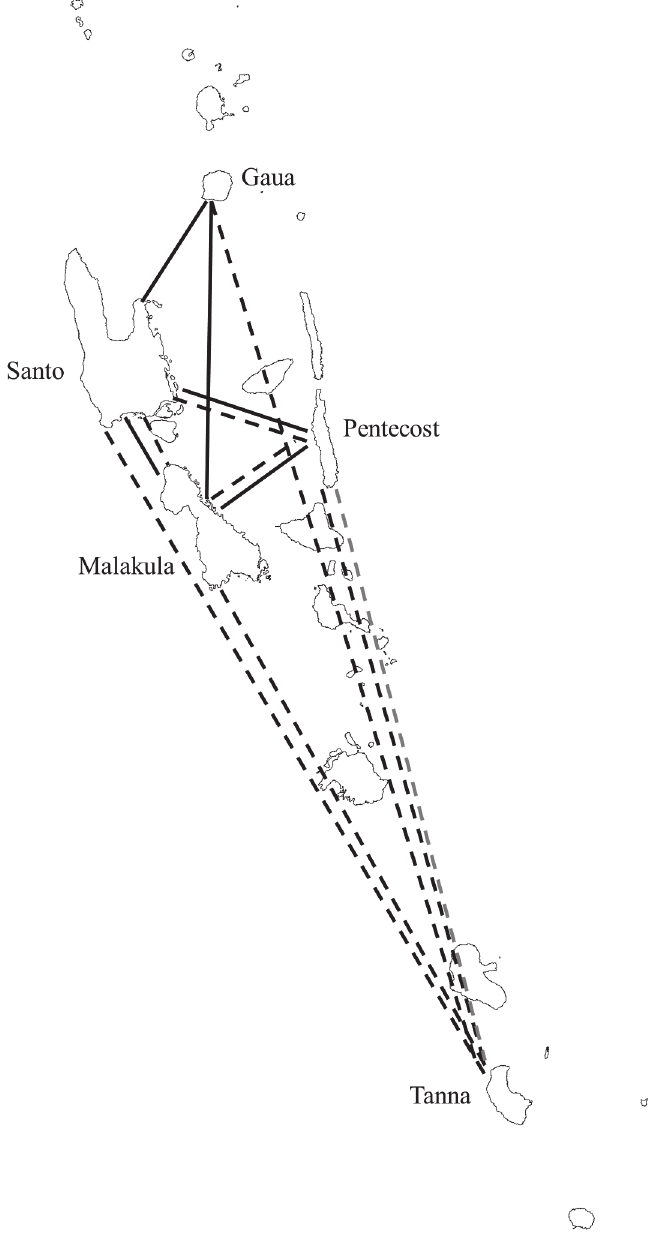
Fig 2. Gene flow among P . falciparum (gray) and P . vivax (black) populations from five islands in Vanuatu. Solid lines represent inferred gene flow based on merozoite surface protein 1 ( msp1 ) F ST genetic distances, while dotted lines represent gene flow based on circumsporozoite protein ( csp ) distances. No gene flow was observed in P . falciparum msp1 . The map of Vanuatu was provided by DIVA-GIS.